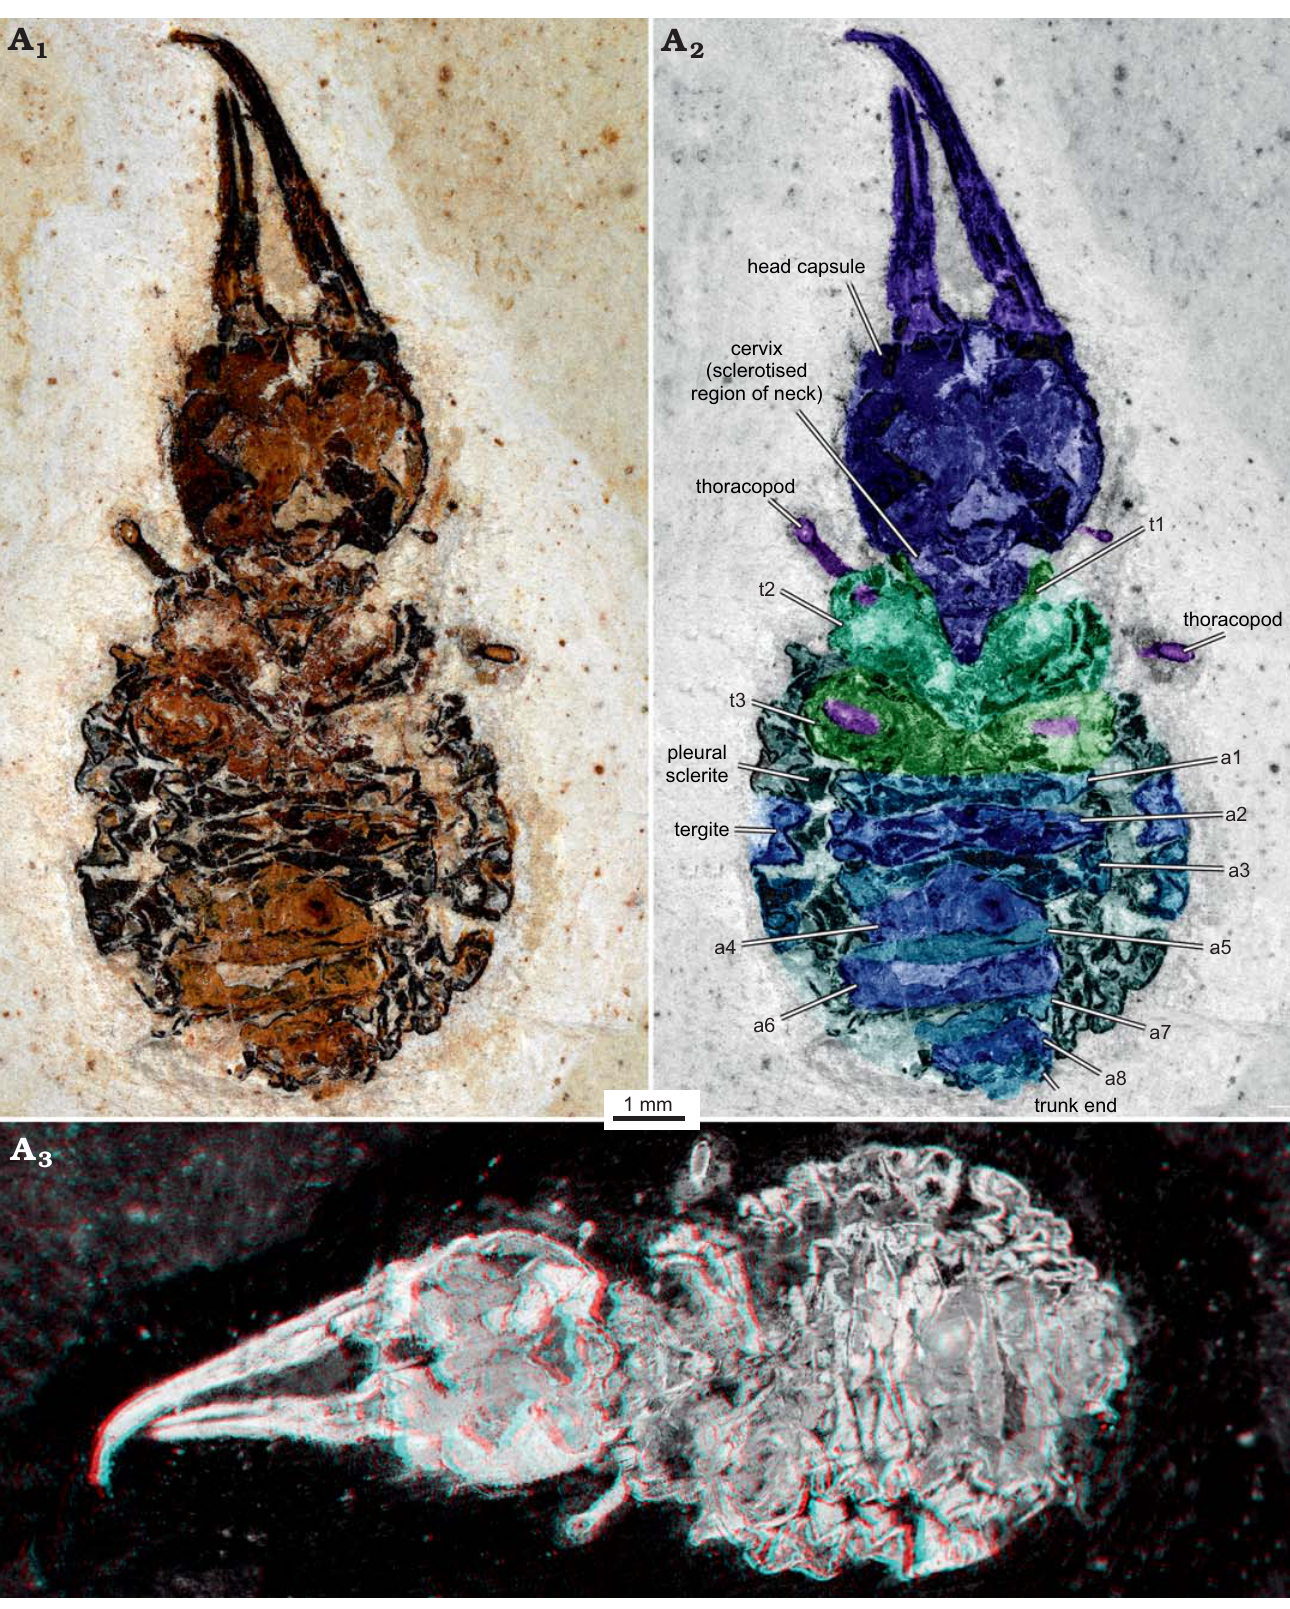
Fig. 2. Myrmeleontiformian lacewing larva (MfN MB.I 2157) from the Crato Formation, Aptian, Lower Cretaceous, Brazil. Photograph in normal light (A 1 ), colour-marked version (A 2 , matrix digitally amended), stereo-image (A 3 ), please use red-cyan glasses to view. Abbreviations: a1–a8, abdomen segment 1–8; t1–t3, thorax segment